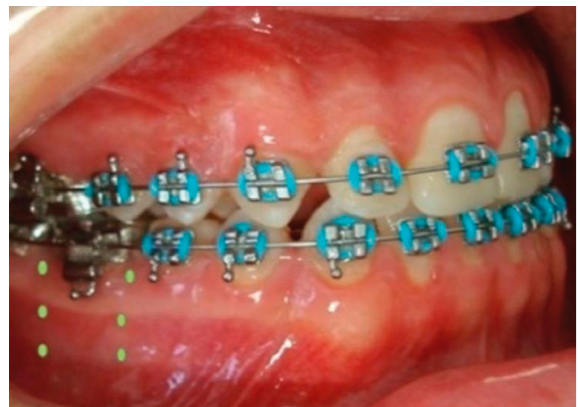
Figure 1: Points of laser irradiation in the buccal region of the right mandibular first